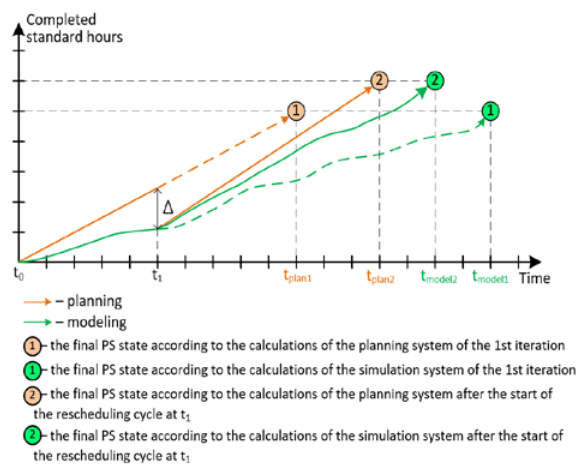
Fig. 3. Graphs of changes in the planned and simulated state of the PS during the implementation of the production program with the implementation of the rescheduling cycle As can be seen from figure 3, the graph contains one rescheduling cycle at the point t1, at which the critical deviation (value Δ) of the simulated PS state from the planned one, expressed in the form of standard hours worked, was determined. The idea of implementing iterative interaction between the simulation system and operational scheduling systems is that during the simulation process, the planned and simulated work volumes are compared, expressed in standard